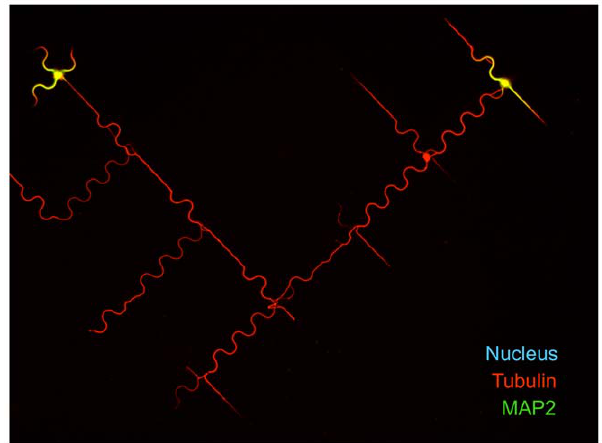
Figure 5. 7 DIV neurons spread over DW4 patterns. Dendritic marker MAP2 (green), microtubules (tubulin in red) and nuclei (Hoechst staining, blue). Scale bar=40 m m. Once formed, the axon developed freely over hundreds of microns along either straight or curved paths following the global organization of DW4 patterns arranged in a